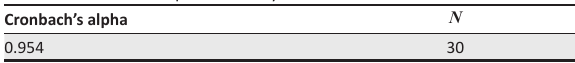
TABLE 2: Cronbach’s alpha reliability test statistics.